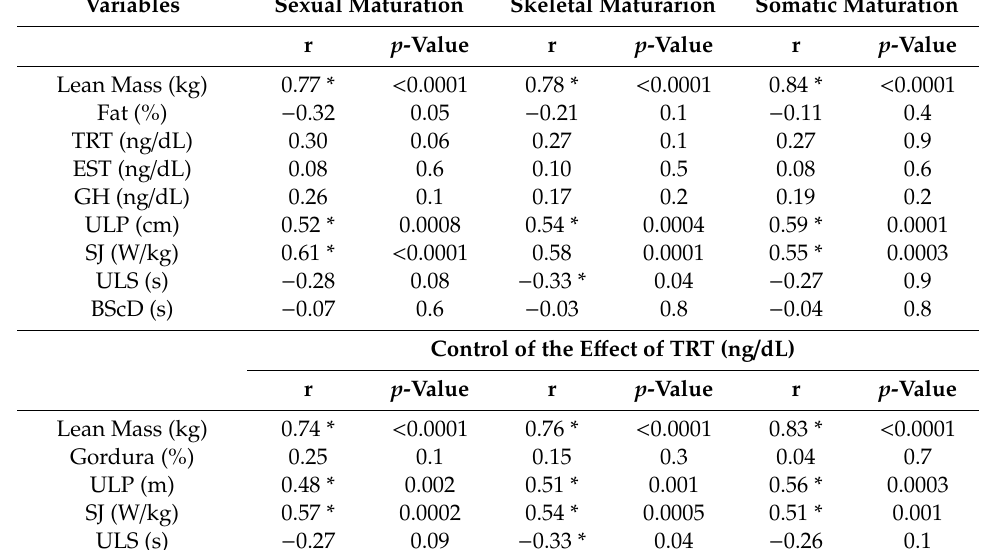
Table 3. Correlations of biological maturation with the study